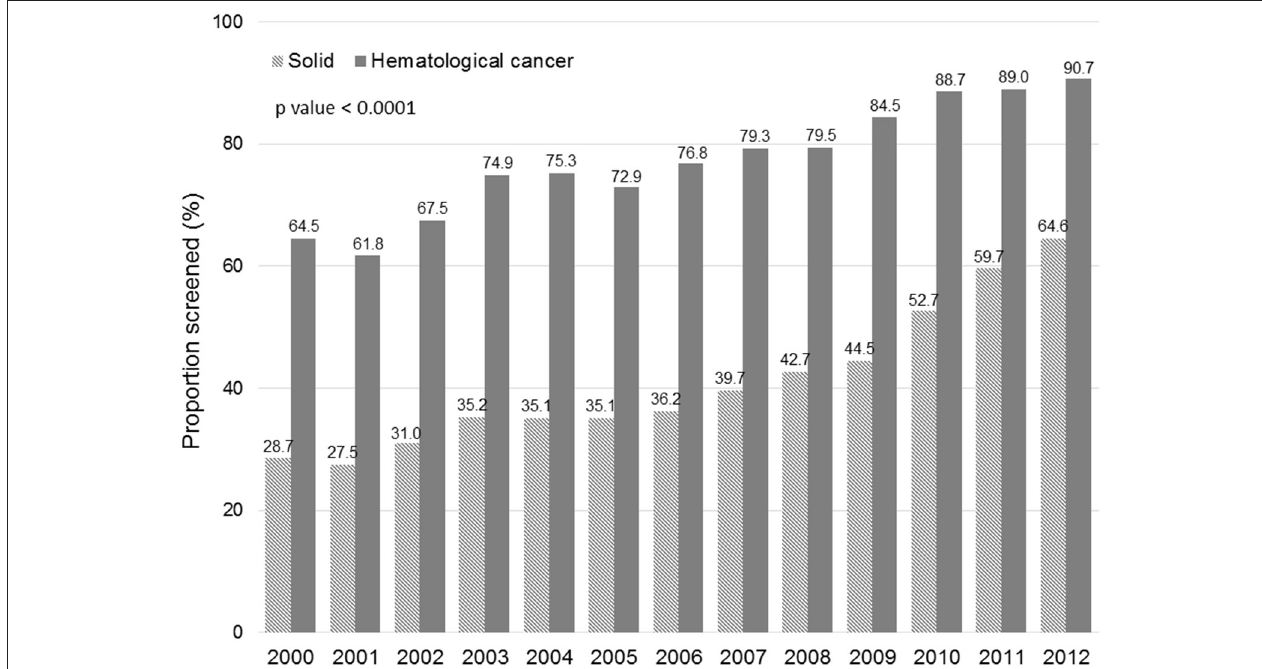
FIGURE 2 | Changes in the annual HBV screening rate in solid and hematological cancers.